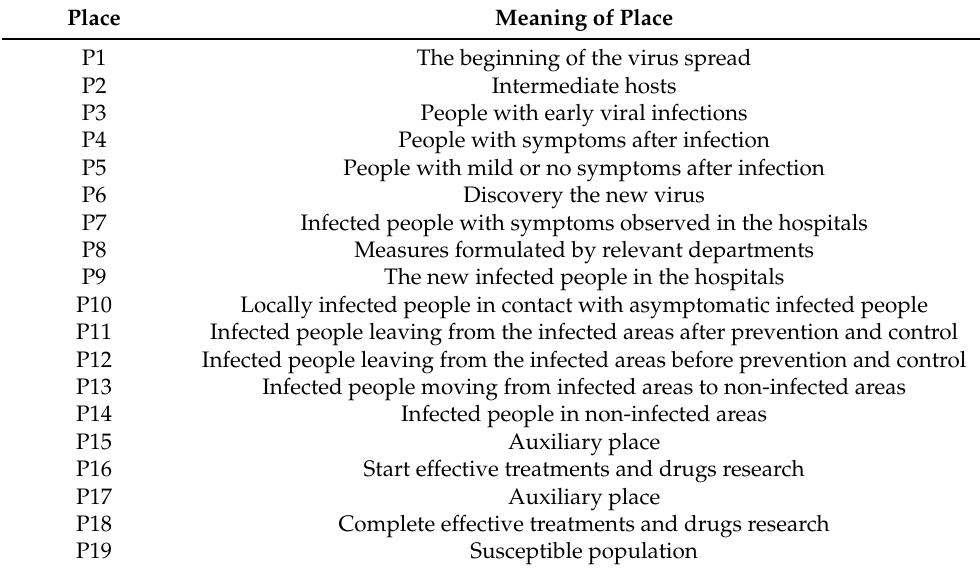
Table 1. Meanings of places of the GSPN model in Figure 3.